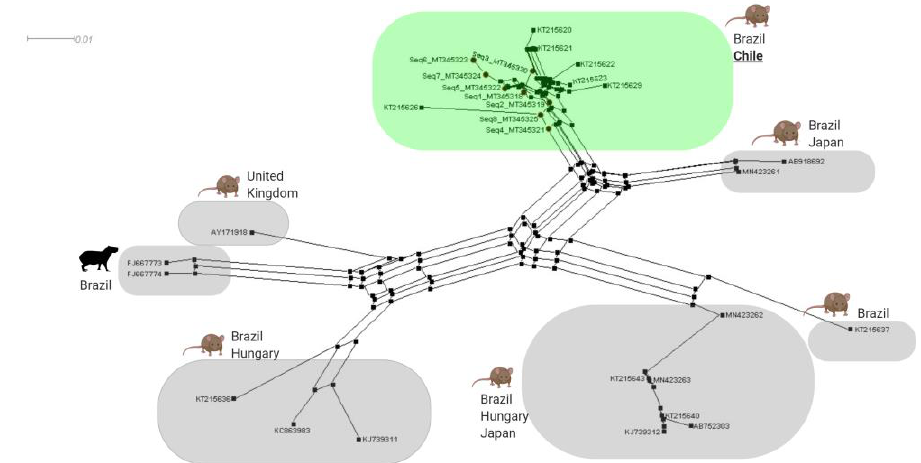
Figure 5. SplitsTree analysis generated by Neighbor-net and uncorrected P distance of hemotrophic Mycoplasma spp. 16S rDNA sequences obtained from rodents sampled in the present study, compared to hemoplasmas previously detected in Brazil, Hungary, Japan, and the United Kingdom. Present study Accession numbers (Chile) are preceded by Seq 1–8, respectively, englobed in the green cluster.